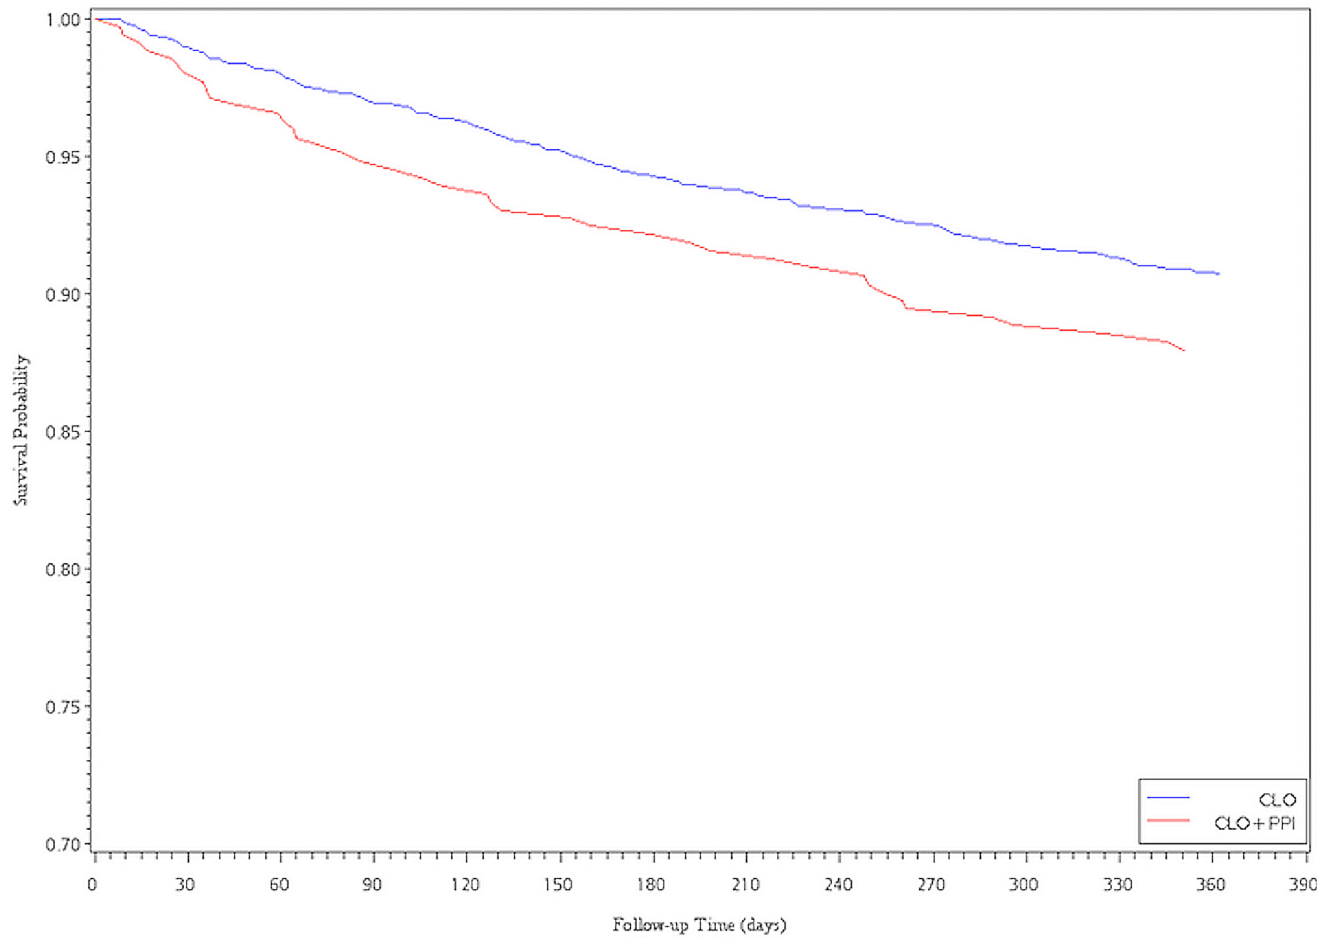
Fig 4. Survival analysis of ACS vs. exposure to ClO plus PPI and ClO after PES implantation.